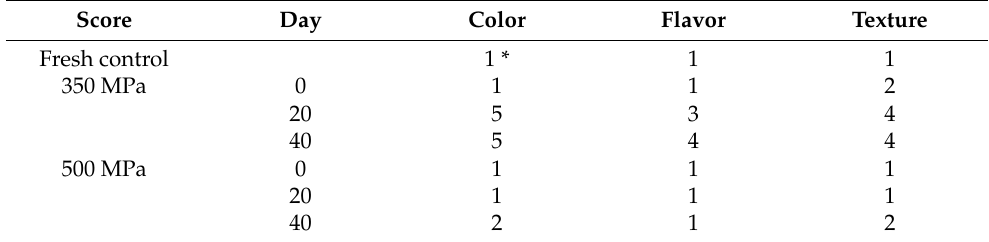
Table 5. Sensory attributes of P. lividus gonads, fresh, after processing, and during 40 days of storage.